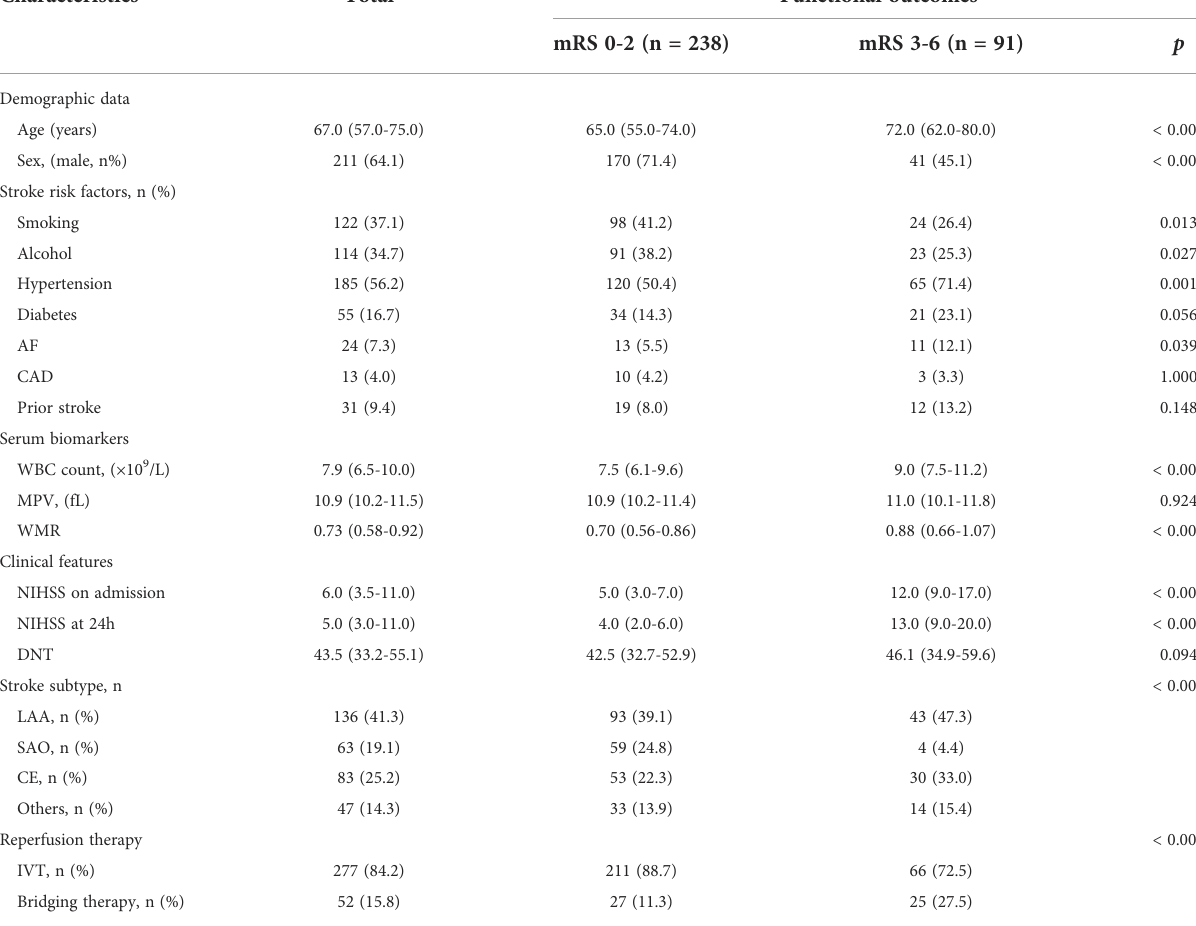
TABLE 1 Characteristics of AIS patients with or without poor function outcomes at 90 days.